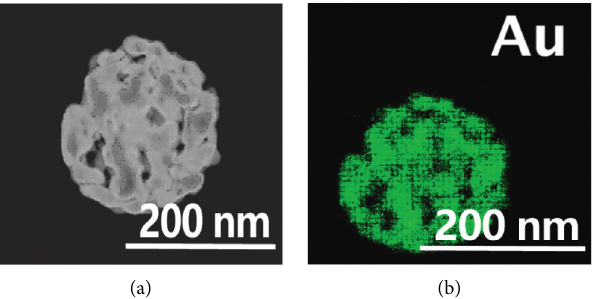
Figure 7: Dark-field TEM image of sample 3 and EDX mapping image of element Au: (a) TEM image; (b) EDX mapping image.